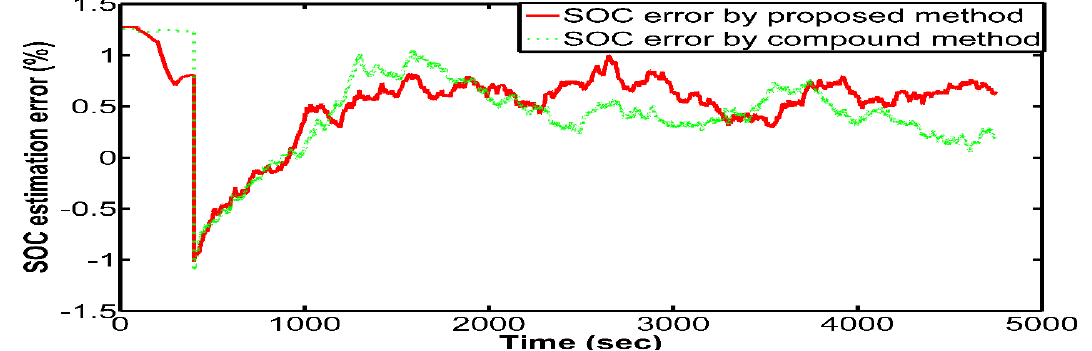
Figure 9. SOC estimation error for the proposed method and the compound method.